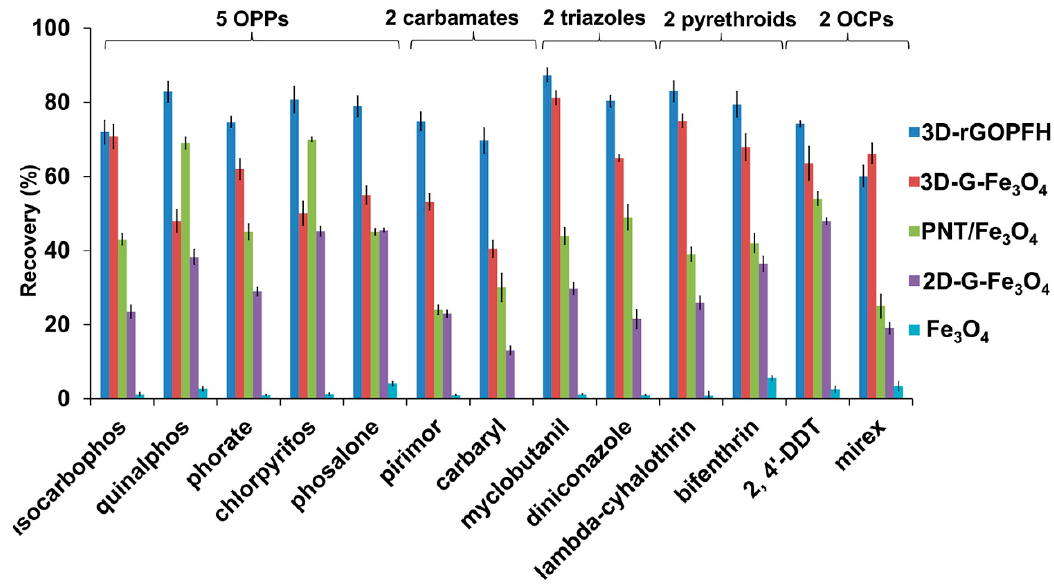
Figure 3. Evaluation of the extraction efficiency for different insecticides using different magnetic sorbents. The standard deviation (SD) bars were marked ( n = 5).